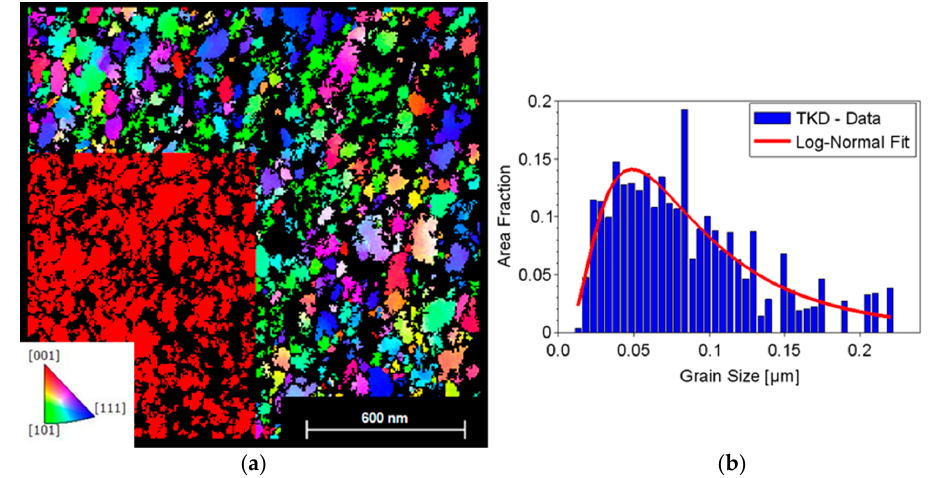
Figure 7. ( a ) Inverse pole figure map of Cu 55 Co 45 , taken at a radius of ~10 mm in an axial direction. As an overlay in the lower left part, the Cu-phase map (fcc–phase map, respectively) of the identical area is shown. After the clean-up, all identified grains are found to be fcc. No hcp-particles can be detected. ( b ) Aggregated grain size distribution from four TKD scans. In total, 1648 grains were taken into account.